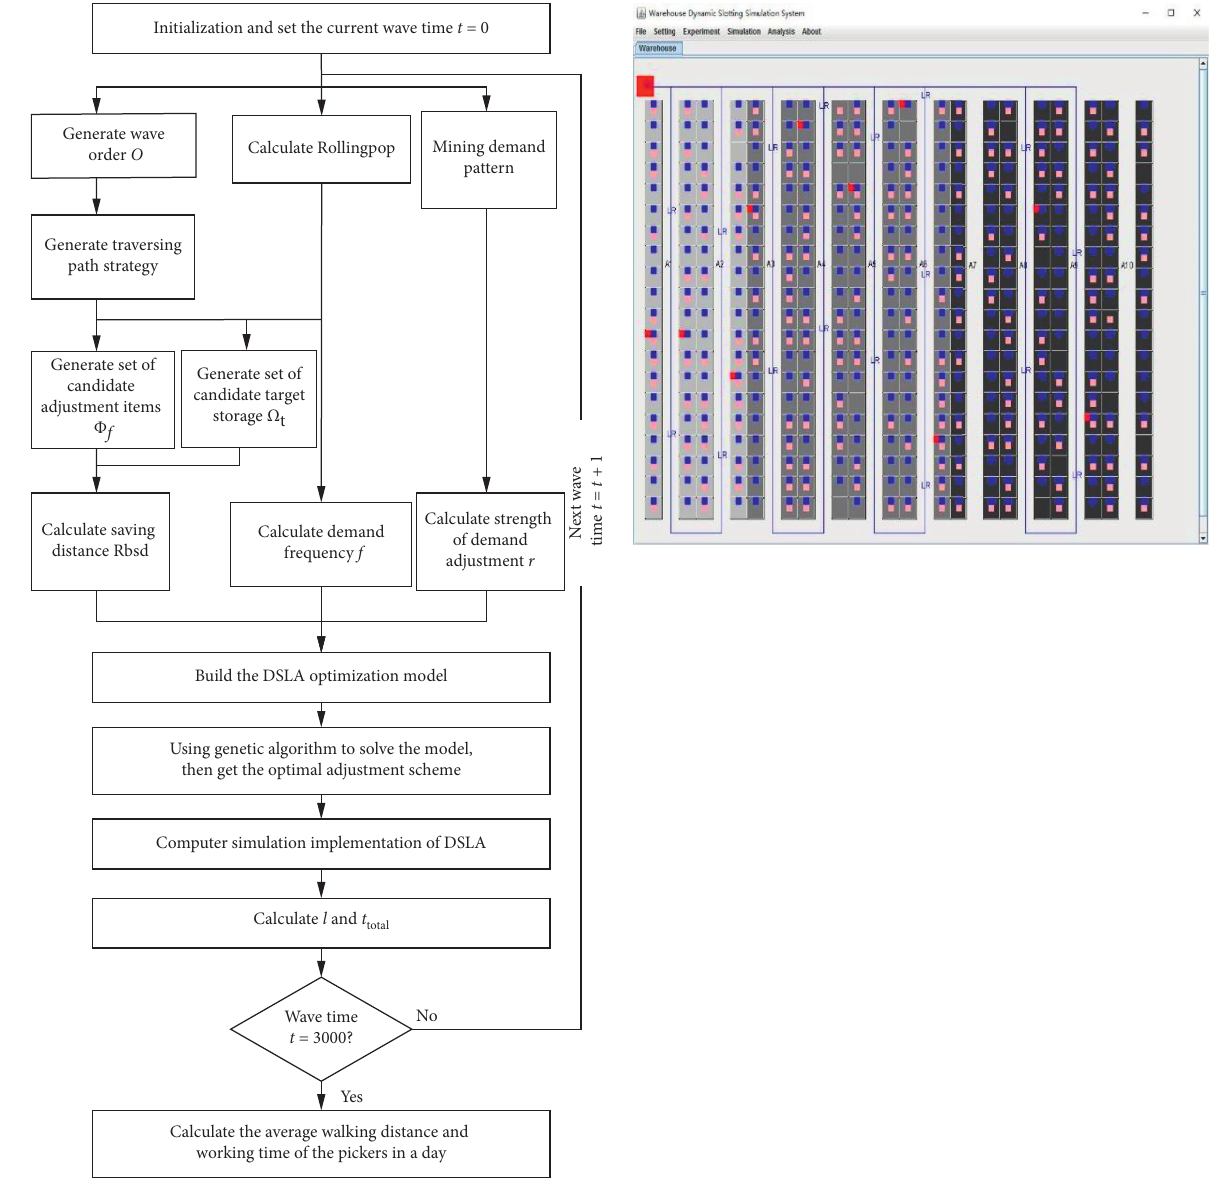
Figure 4: DSLA simulation flowchart and software: (a) DSLA simulation flowchart and (b) DSLA simulation